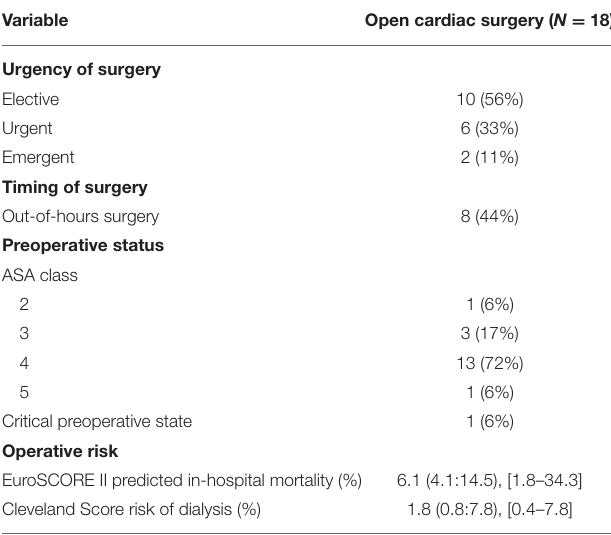
TABLE 4 | Preoperative status and operative risk of nonagenarians undergoing open cardiac